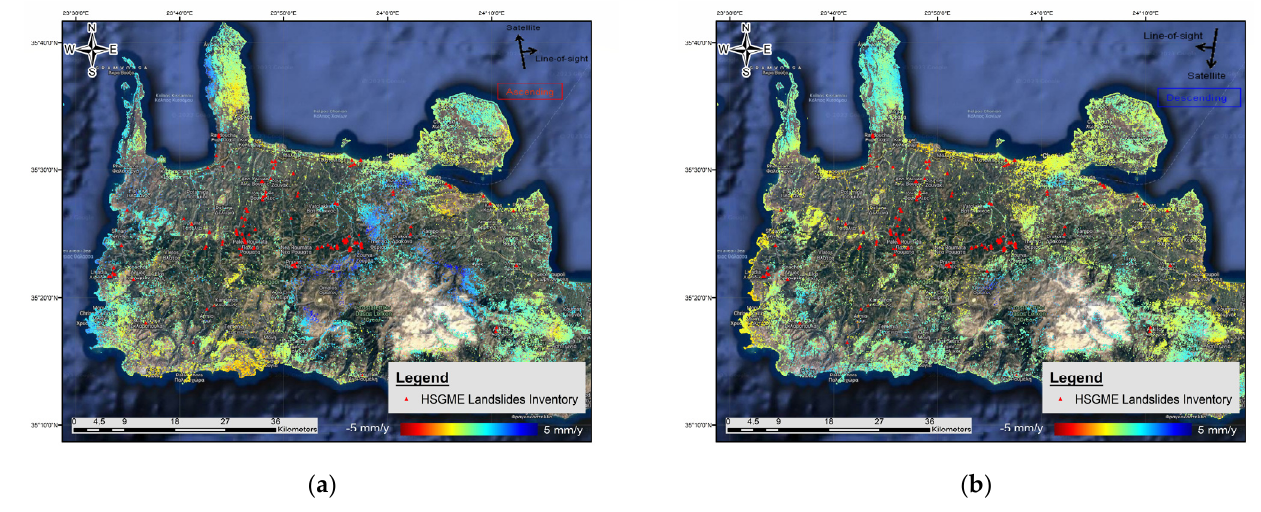
Figure 3. LOS displacements for the ascending ( a ) and descending ( b ) satellite pass, along with the initial landslide inventory provided by the HSGME.